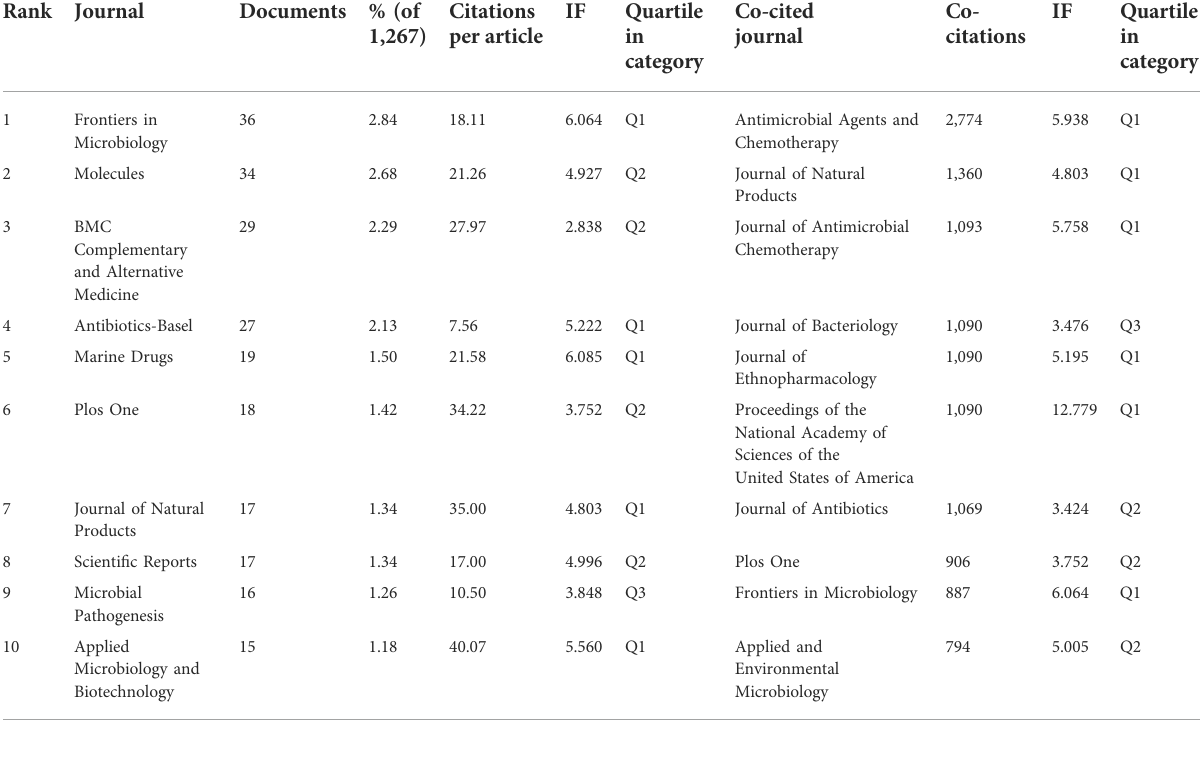
TABLE 3 The top 10 journals and co-cited journals related to resistance of natural products to MDR bacteria.